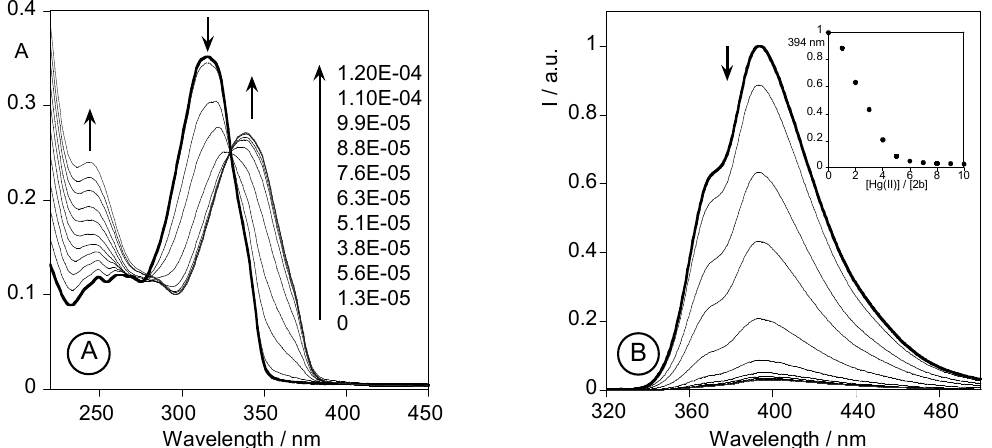
Figure 1. Spectrophotometric titration (A) and fluorimetric titration (B) of an ethanolic solution of 2b with a standard solution of Hg(CF